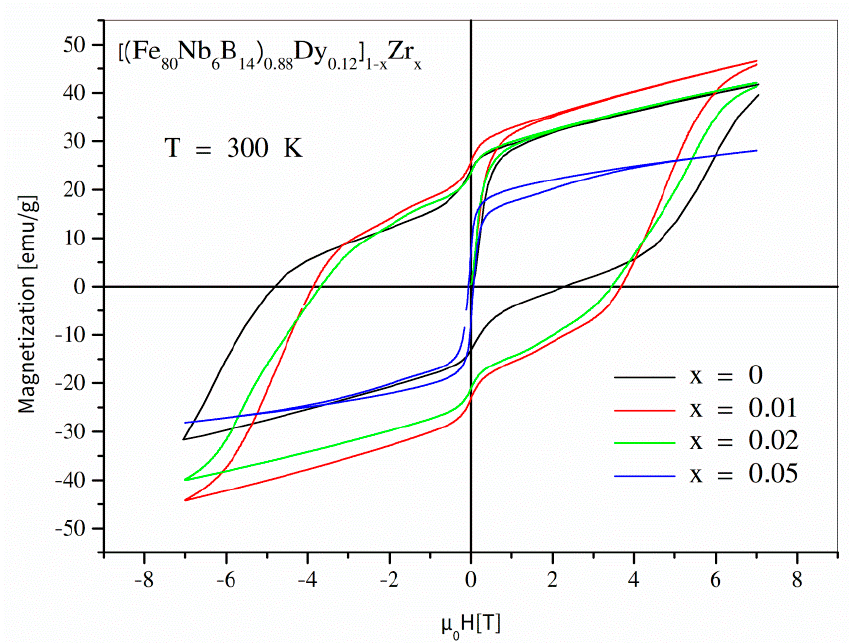
Figure 4. Hysteresis loops for the [(Fe 80 Nb 6 B 14 ) 0.88 Dy 0.12 ] 1 − x Zr x (0 ≤ x ≤ 0.05) alloys measured at room temperature.